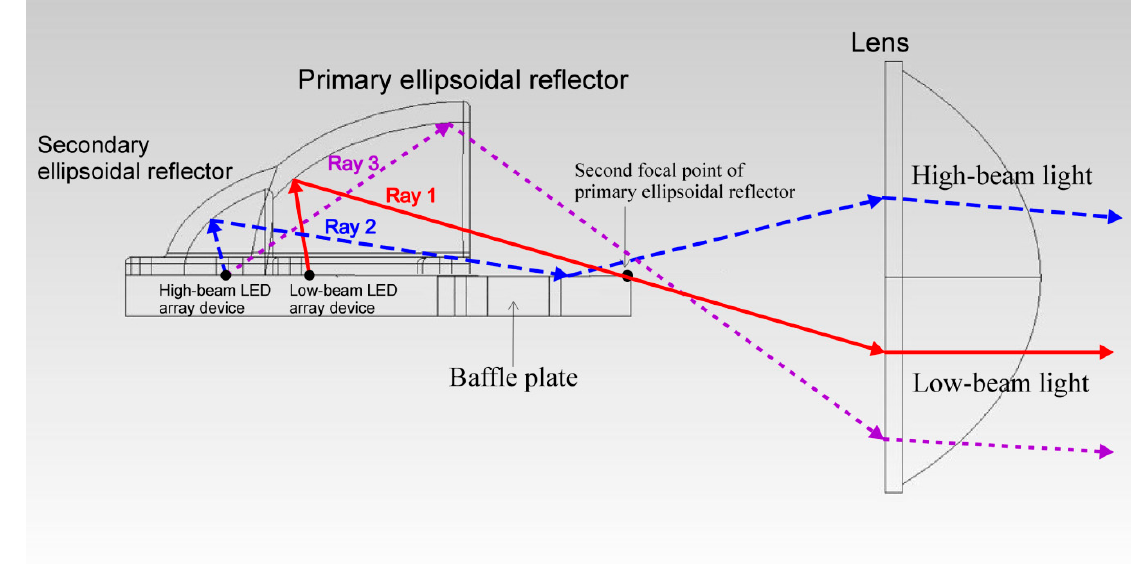
Figure 1. The structure of the single headlamp with low- and high-beam light in this study.